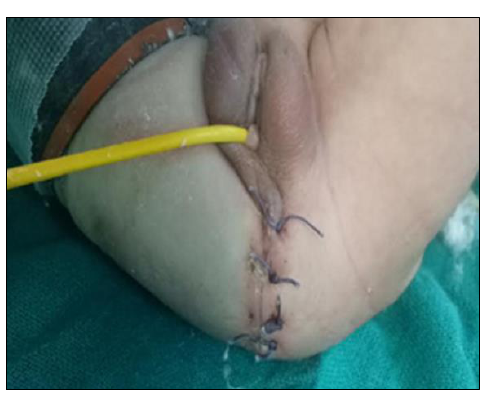
Figure 1: Showing dug perineum. On admission to our center on day 5 of life, the general condition was sick. The anterior fontanelle was sunken. Capillary refilling time was >3 seconds with loss of skin turgor. Her heart rate was 144/min, systolic blood pressure was 54 mm Hg, and a respiratory rate of 35/min. Her upper abdomen was distended. The perineum had two openings (urethra and vagina). The anal opening was absent with a recently sutured midline perineal wound (Fig.1). No other gross malformations were apparent on general physical